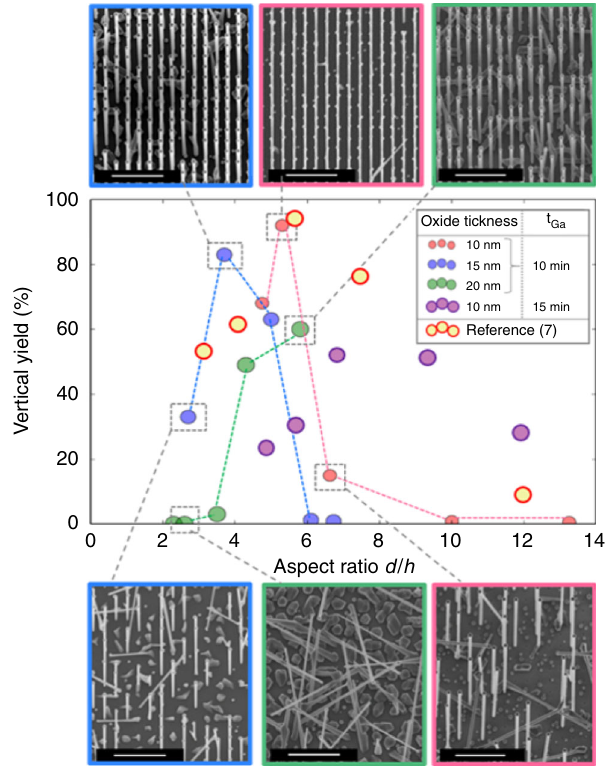
Fig. 1 Optimization of the yield of vertical GaAs nanowires by the hole aspect ratio. Different values of the aspect ratio d / h were obtained using three different oxide thicknesses h of 10, 15, and 20 nm (corresponding to the red, blue, and green data points, respectively), and different diameters d . The hole arrangement and atomic force microscopy (AFM) pro fi le measurements of the holes can be found in Supplementary Note 1. All samples were grown under the same conditions (details in supplementary material, Supplementary Figs. 1, 2). 20 o titled SEMs shown in the inserts illustrate the samples with the best and worst yields for each h where the nanowires were formed (yield that equals zero for the case of h = 15 and 20 nm only parasitic growth was formed); color code of the insert frames is the same as for the data points. Scale bars correspond to 2 μ m. Supplementary Note 2 gives the yield versus the aspect ratio over the full arrays. The maximum yield is obtained for the aspect ratios between 4 and 6. The yellow points represent the results of ref. 7 , following the same